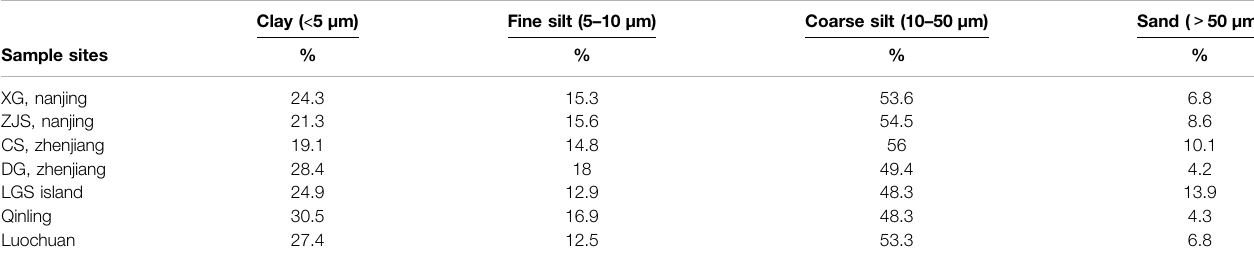
TABLE 7 | Comparison of grain size composition of loess in the LRYR and on the CLP (Li, 1998; Liu, 2006; Xu et al., 2016; Chen et al., 2017).